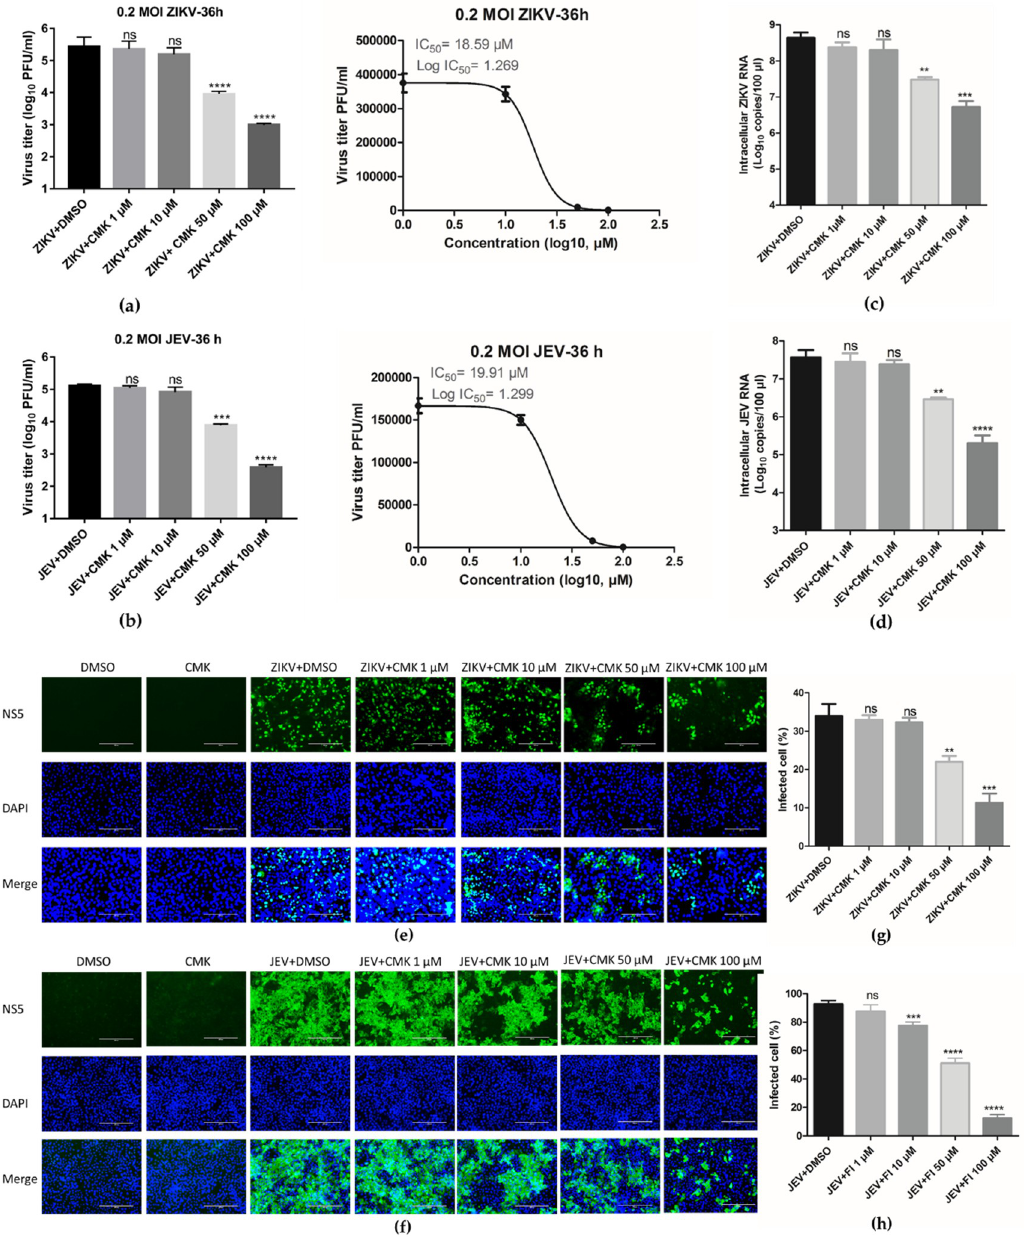
Figure 4. Antiviral assessment of dec-RVKR-cmk against ZIKV and JEV in a dose-dependent manner. Vero cells were infected with ZIKV or JEV at 0.2 MOI followed by dec-RVKR-cmk treatment using the indicated concentration. Right panels ( a , b ) indicate virus titer while left panels indicate IC50 of dec-RVKR-cmk against the indicated MOI of ZIKV and JEV. ( c ) ZIKV-0.2 MOI and ( d ) JEV-0.2 MOI infected Vero cells were treated by dec-RVKR-cmk in a dose-dependent manner and then analyzed by qRT-PCR for absolute genome copies using standard curve of in vitro transcribed ZIKV and JEV RNA at 36 hpi. Meanwhile, infected Vero cells with similar condition of RNA analysis were fixed to analyze virus spreading from infected cells to neighboring cells. Immunofluorescence images of ( e ) ZIKV- and ( f ) JEV-infected Vero cells were acquired at 36 hpi, and quantified ( g ) ZIKV and ( h ) JEV immunoreactive positive cells to visualize the inhibition of infection in a dose-dependent manner. Data are presented as the mean ± SEM from three independent